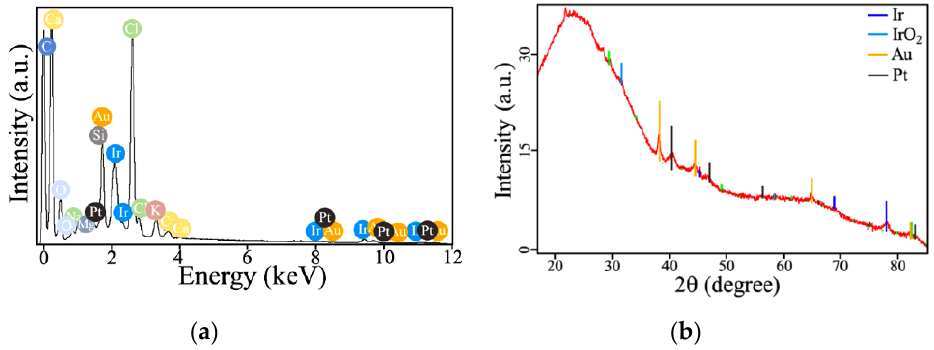
Figure 3. EDX spectrum ( a ) and XRD pattern ( b ) of iridium-gold-platinum (Ir-Au-Pt) microstructures.